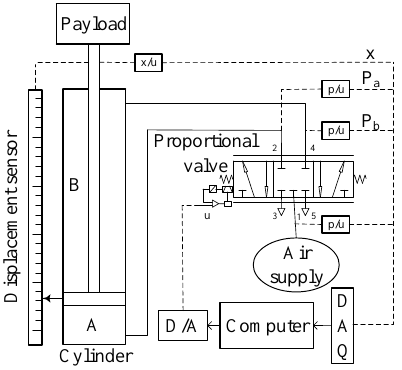
Figure 1. Schematic of the single-rod pneumatic cylinder servo system.